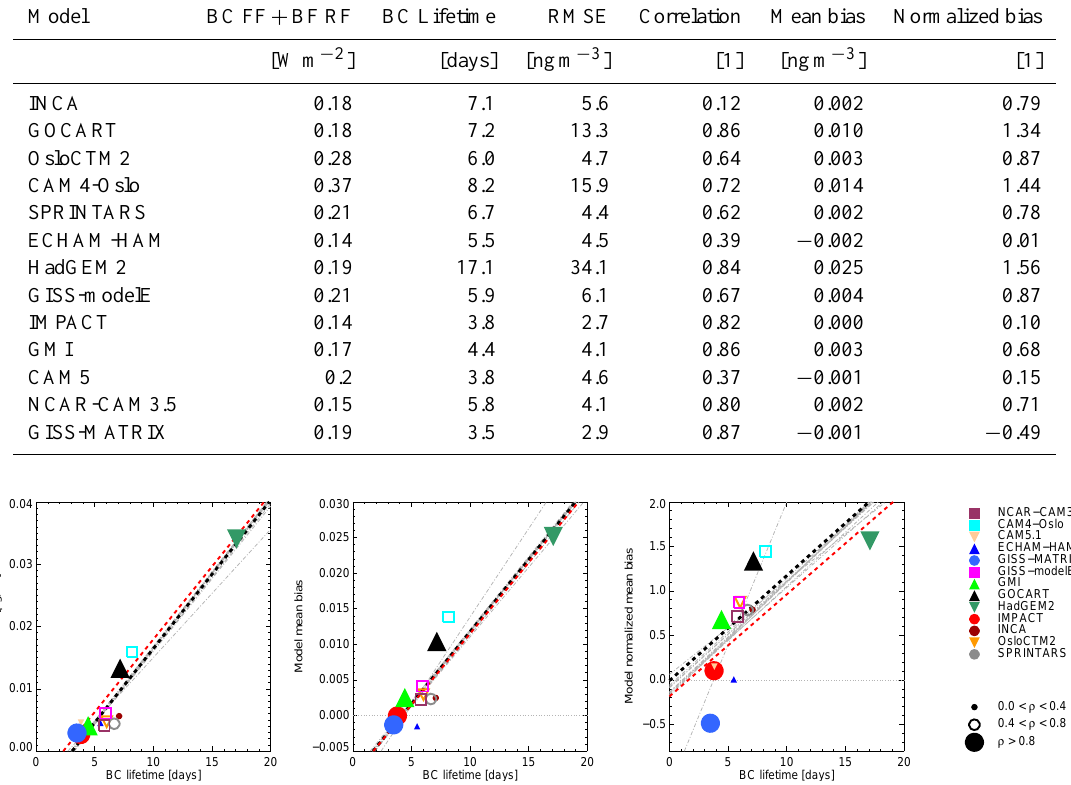
Figure 3. Modelled global BC lifetime plotted versus RMSE, mean bias and normalized mean bias, between model prediction and ob- servations for the five HIPPO regions (P1–P5). Each RMSE or bias calculation is based on 72 data points. The symbol size indicates the corresponding Pearson correlation coefficient. The black dashed line shows a least-squares regression line with all models included. The grey lines show regressions with one model removed. The red dashed line shows a regression using only models with ρ> 0 .